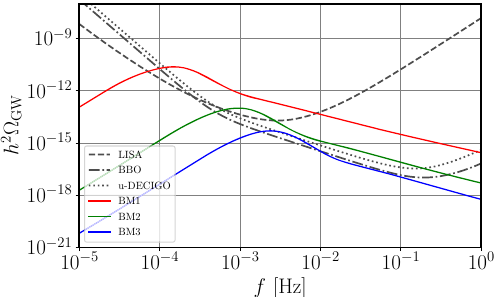
Fig. 3 The GW spectra for the three benchmark FOPTS solution listed in Table I have been plotted in a frequency domain that allows to make comparisons with the sensitivity curves of LISA, BBO and u-DECIGO